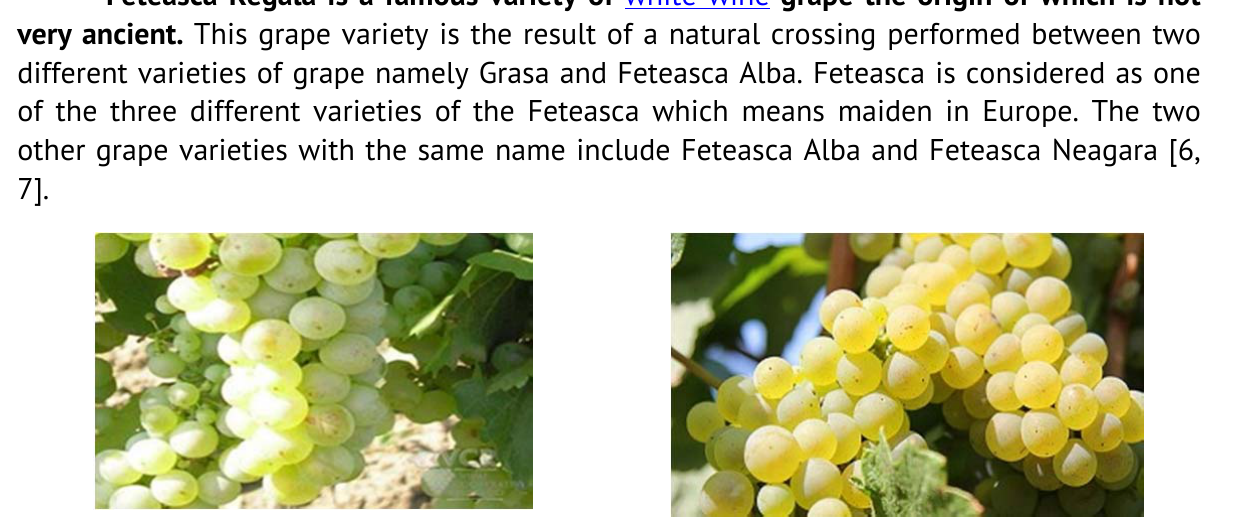
Figure 1 . Feteasca Alba grapes. Figure 2. Feteasca Regal ă grapes.